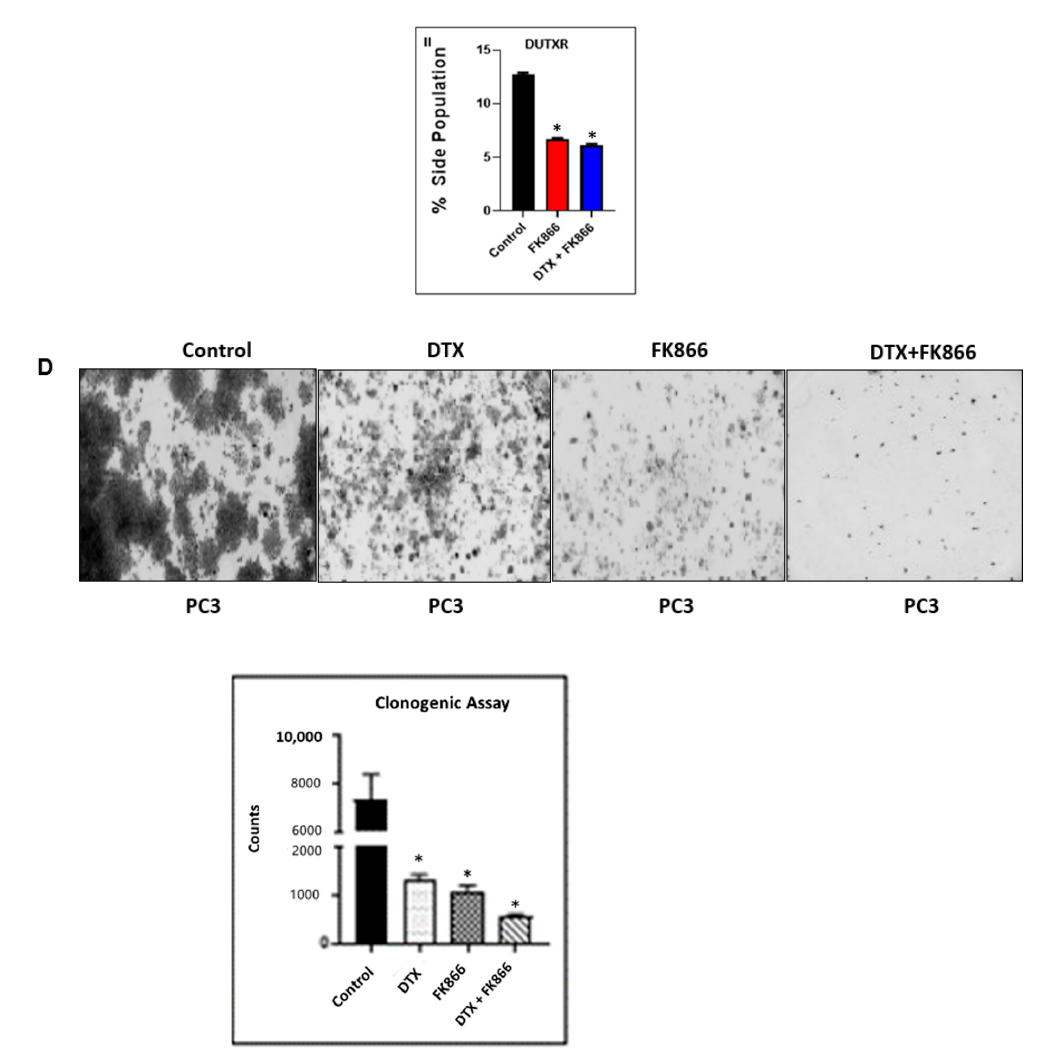
Figure 5. ( A – B ). FK866 treatment reduced cell density and changed nuclear morphology. ( A ) As- sessment of cellular morphology: I-III. Representative figures showing the effect of the primary (DTX) and secondary (FK866) drugs on cell count and cell morphology of mCRPC cells. The images were captured on the PC3-Luc cells before (0 h) and after (48 h) FK866 treatment either as a single agent or in combination. Microscopy results show significantly higher cell death in combination treatment compared to single-drug treatment for all cell lines; IV. ImageJ data analysis showed a significant difference in cell density for both FK866 single-agent and DTX + FK866 combination treatments. Results show significantly higher cell death in combination treatment at combination dose compared to single-drug treatment for PC3cell lines. (Significant value * = p < 0.05.) ( B ) Assess- ment of nuclear morphology. I-III. Representative figures showing the FK866-based treatment (sin- gle-agent and combination with DTX) on cell nucleus morphology of mCRPC cells. NucBlue Live reagent is frequently used to distinguish condensed nuclei in apoptotic cells. The microscopy im- ages were captured on the PC3-Luc cells before (0 h) and after (48 h) following treatment. Micro- scope images showing treatment effect on the cell lines PC3. Similar results were obtained for all mCRPC lines; IV. ImageJ data analysis showed a significant difference in cell density and nucleus damage for FK866 regimens. (Significance p -value * = p < 0.05.) Figure 5C,D. FK866 potentially de- creased stem cell load in AVPC cells. ( C ) Side population: Representative figure showing side pop- ulation analysis following FK866 single agent and FK866 + DTX combination treatments in mCRPC reduced load of side population compared to control (no drug treatment). Side populations were